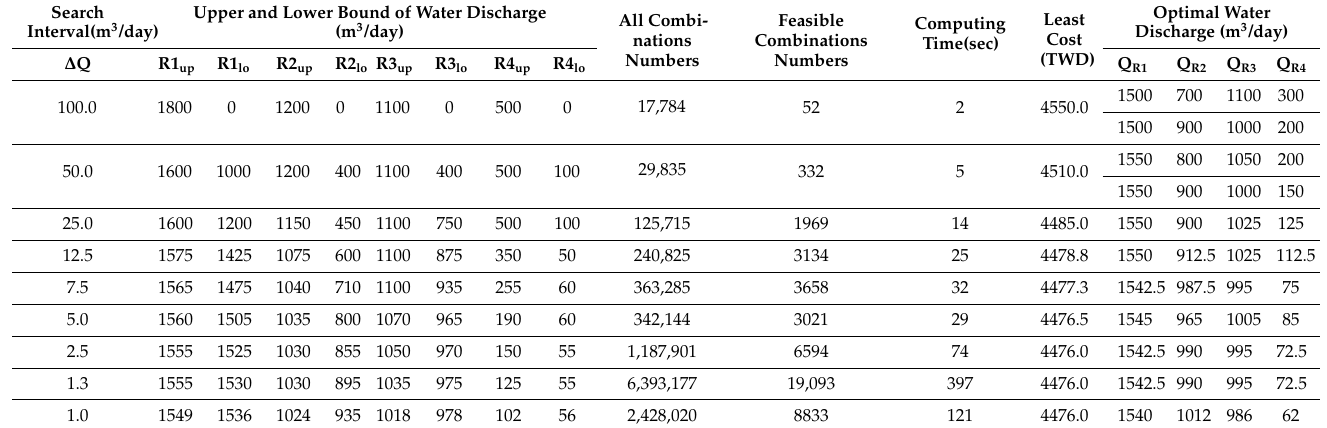
Table 4. Uniform grid sampling procedure (UGSP) optimization results.